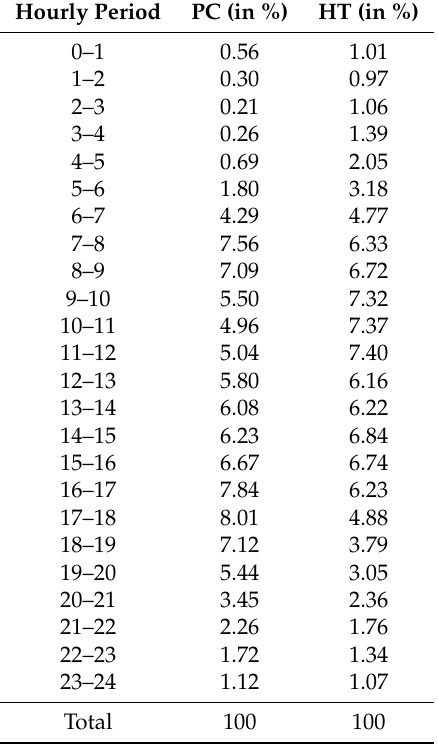
Figure 3. Average daily traffic distribution; passenger cars (PC) and heavy trucks (HT). See Table 5 for details. Table 5. Average daily traffic distribution per 1 h period (in %); passenger cars (PC) and heavy trucks